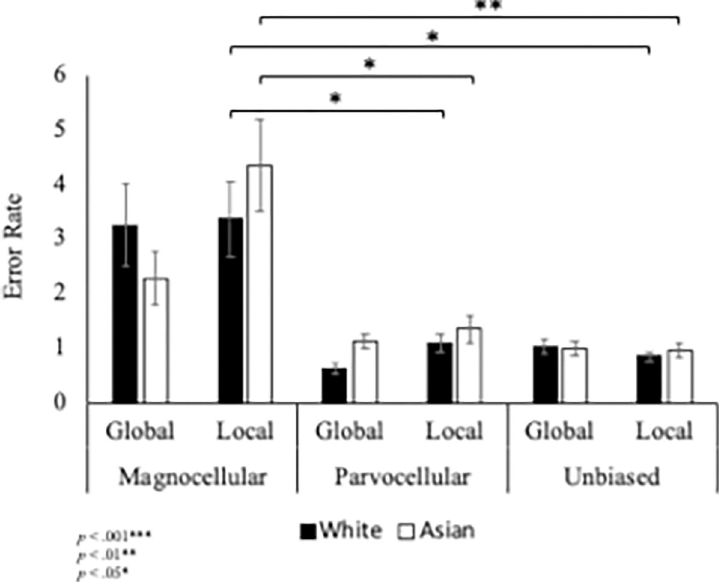
Fig 2. Accuracy results. More errors were made identifying the target in the magnocellular condition compared to the parvocellular and unbiased conditions when it was presented at the local level for both White and Asian individuals. Error bars show +/- 1